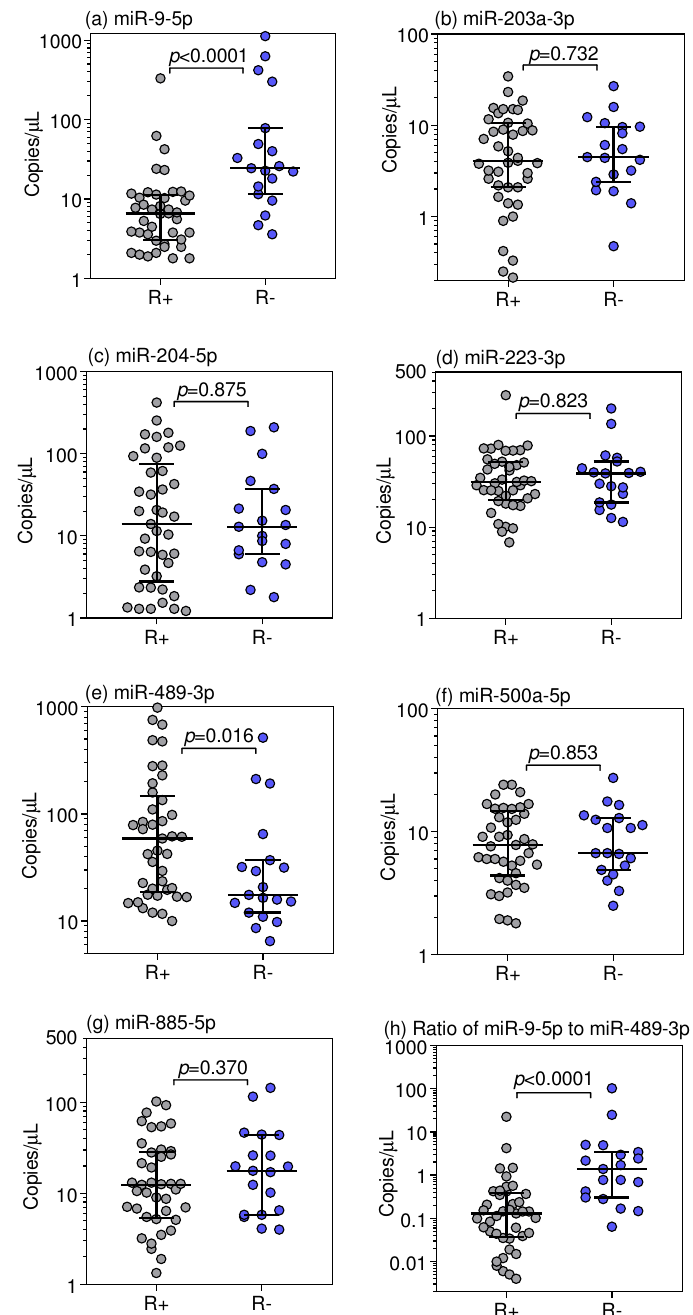
Figure 3. miRNA expression data in nephrectomized tumor samples of mRCC patients with different responses to first-line TKI therapy. Using droplet digital RT-PCR, the selected seven miRNAs after pretesting validation by RT-qPCR (see Figure 1 and text in Section 3.3) were measured as shown in the subfigures ( a – g ) in primary tumor samples of metastatic RCC patients who were responders (R+, n = 41) or non-responders (R − , n = 19) to TKI treatment. Furthermore, the ratio of the two significant miRNAs, miR-9-5p to miR-489-3p, was shown in subfigure ( h ). Medians with interquartile ranges are given, and significant differences between the study groups were calculated by Mann-Whitney U